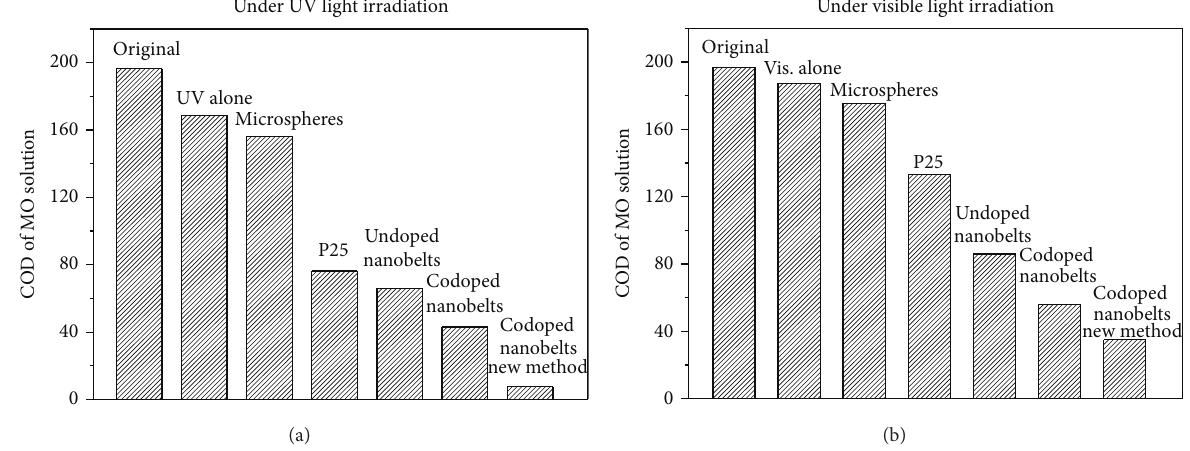
Figure 9: COD removal of the methyl orange solution after the photocatalytic degradation under UV and visible light irradiations [67].